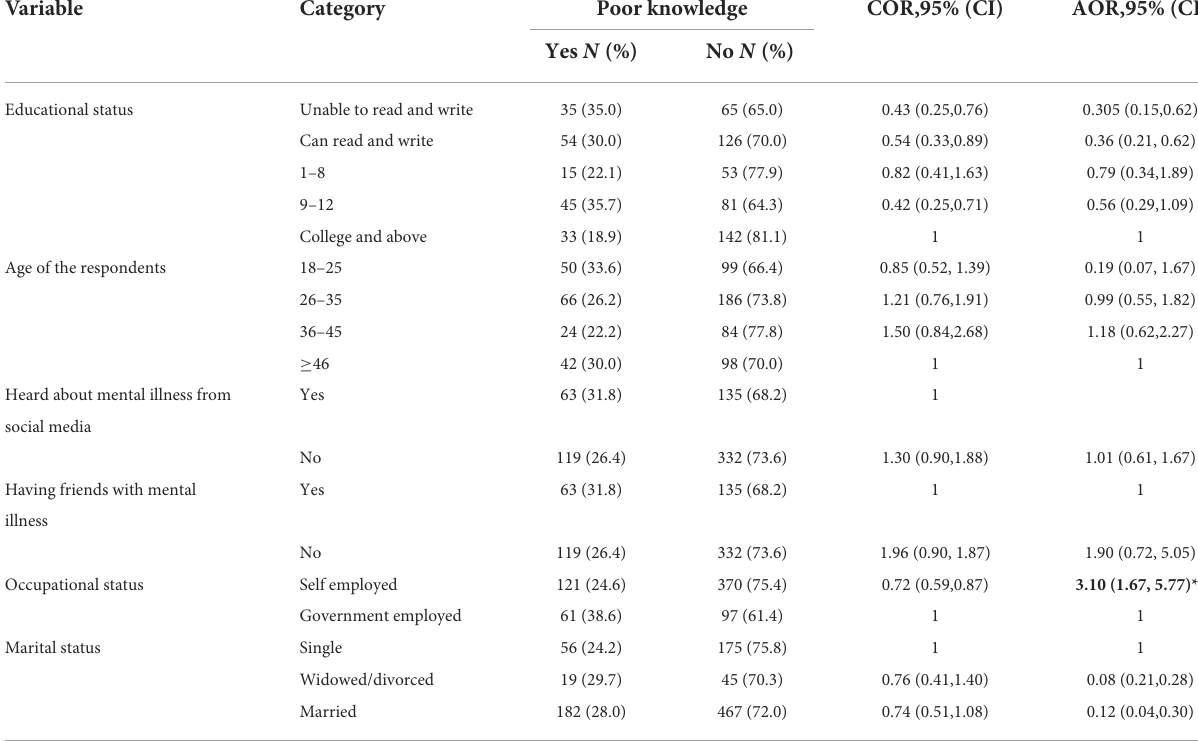
TABLE 2 Bivariate and multivariate logistic regression analysis of factors associated with poor knowledge toward mental illness among Mattu town residents, South West Ethiopia, 2022 ( N = 649). Variable